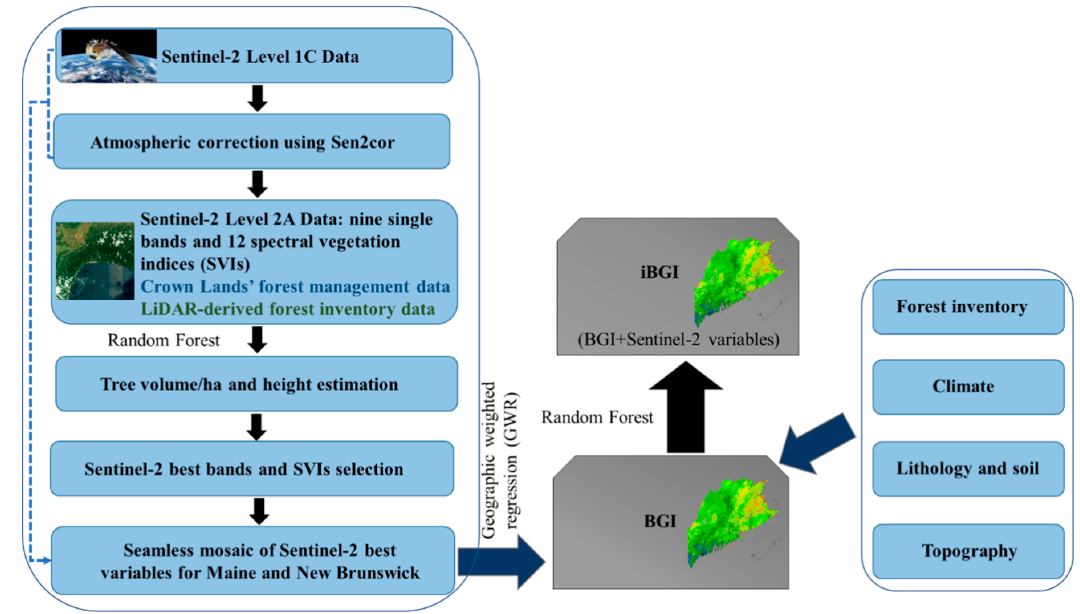
Figure 1. Flowchart showing the methodology of the study (BGI: biomass growth index; iBGI: improved BGI).